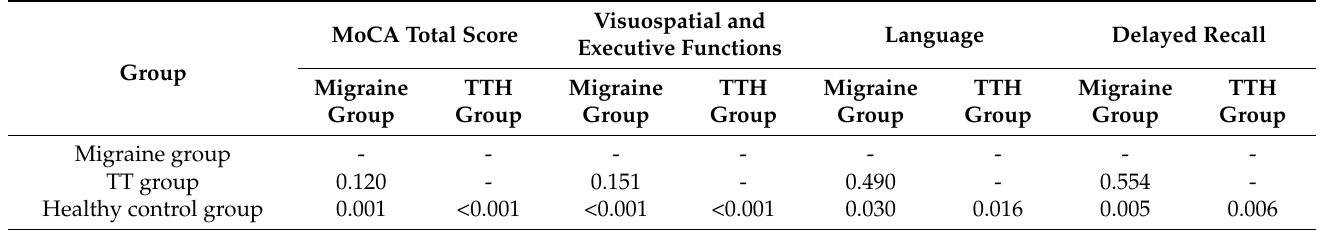
Table 4. Pairwise comparisons of MoCA total scores and scores of visuospatial and executive functions, language, and delayed recall among the three groups ( p values).